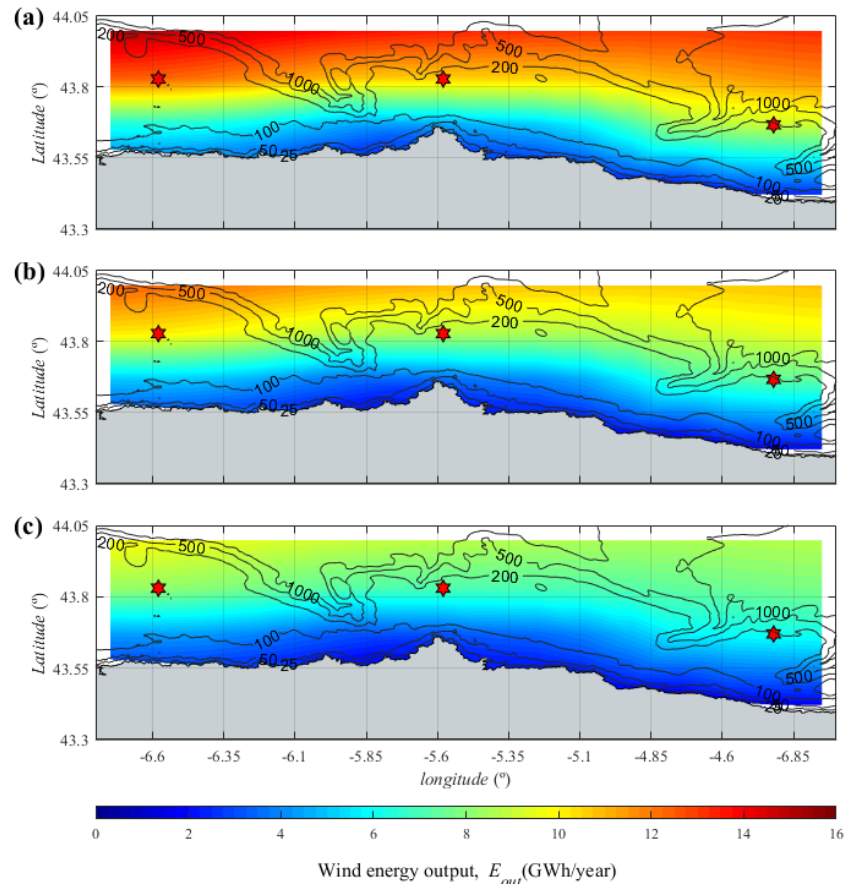
Figure 7. Expected wind energy output ( E w,out ) for three commercial wind turbines: Senvion REpower 6.2M ( a ), Areva M5000 ( b ) and Siemens SWT 3.6 ( c ). The three study sites (West, Centre and East) are marked with red stars. (Water depths in m). Table 3. Capacity factor ( CF , with units of %) of six commercial renewable energy technologies (three wind turbines and three PV panels) at the three study sites. Study Site